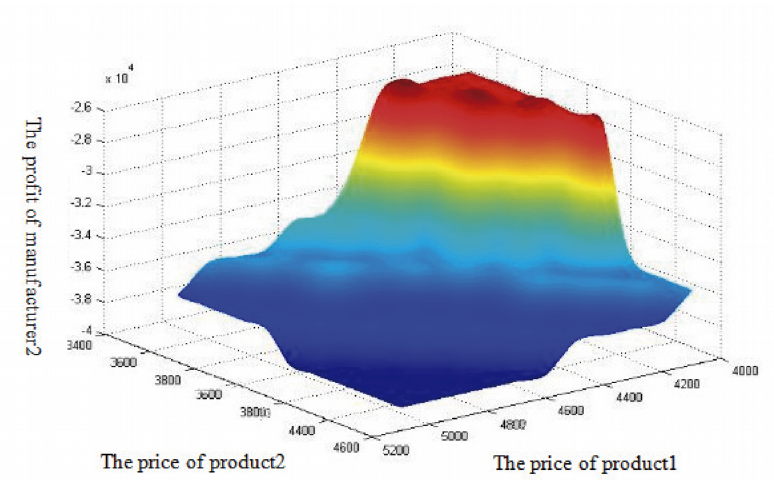
Figure 2. The curve of Manufacturer 2’s profit change with Lenovo computer and HP computer